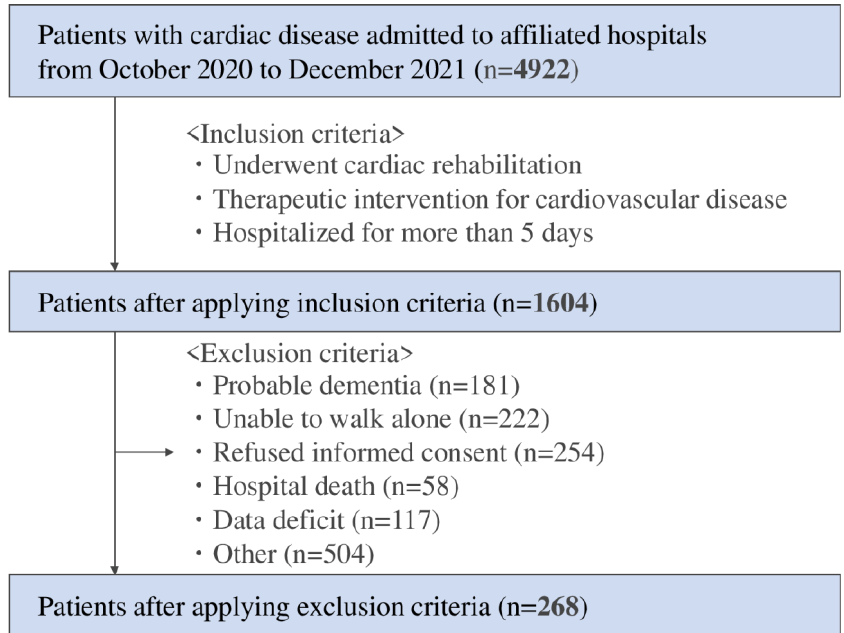
Figure 1. Flow chart of the study participants.